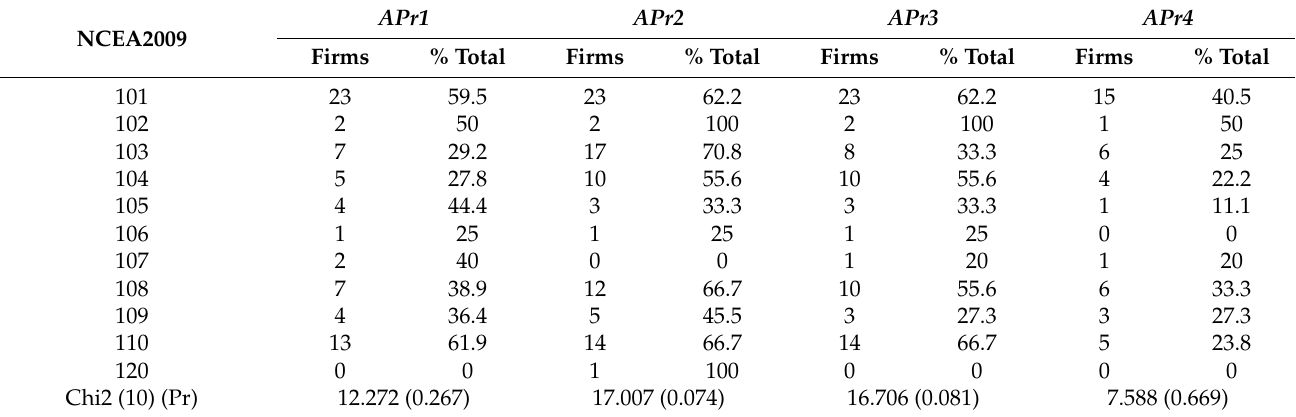
Table 5. Changes carried out in processes according to the branch of